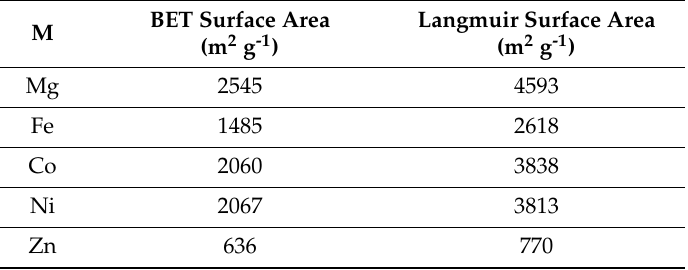
Table 2. Brunauer–Emmett–Teller (BET) and Langmuir surface areas of M 2